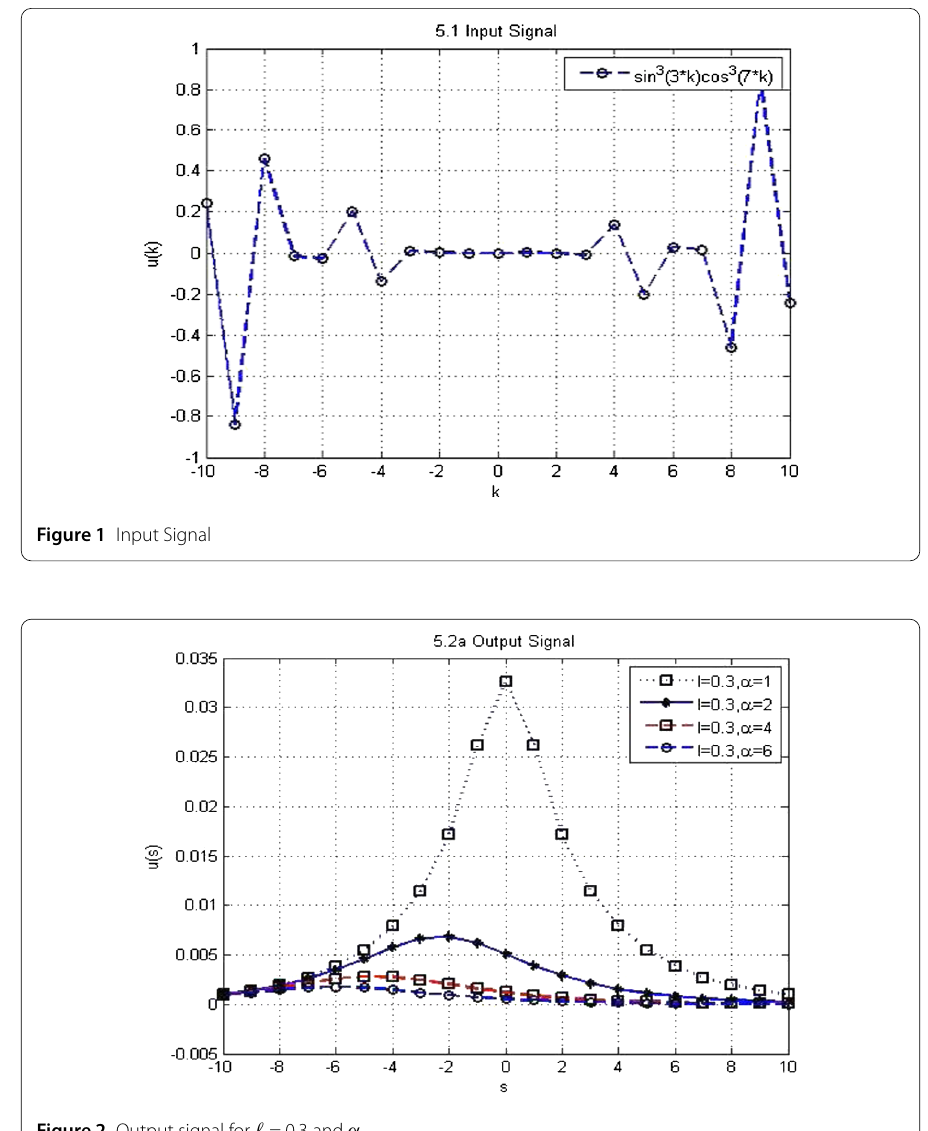
Figure 2 Output signal for (cid:5) = 0.3 and α